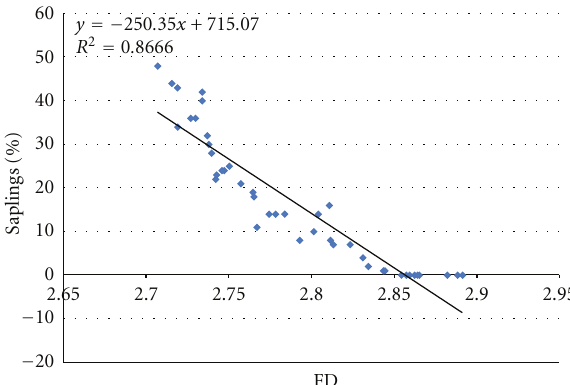
Figure 9: FD versus saplings.